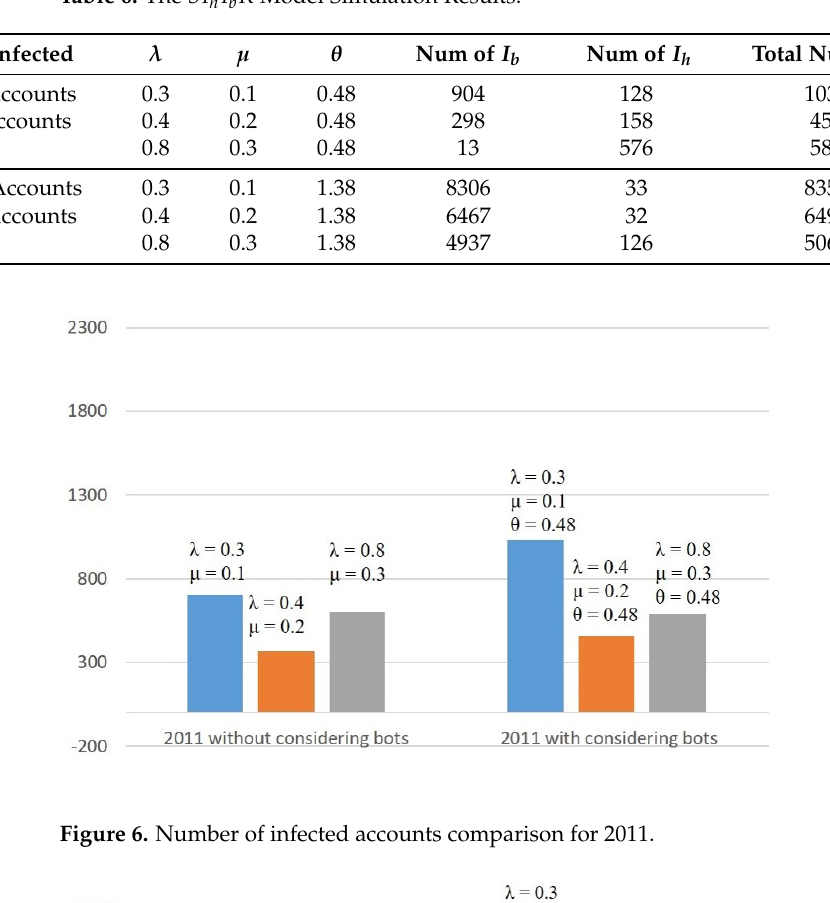
Table 6. The SI h I b R Model Simulation Results.